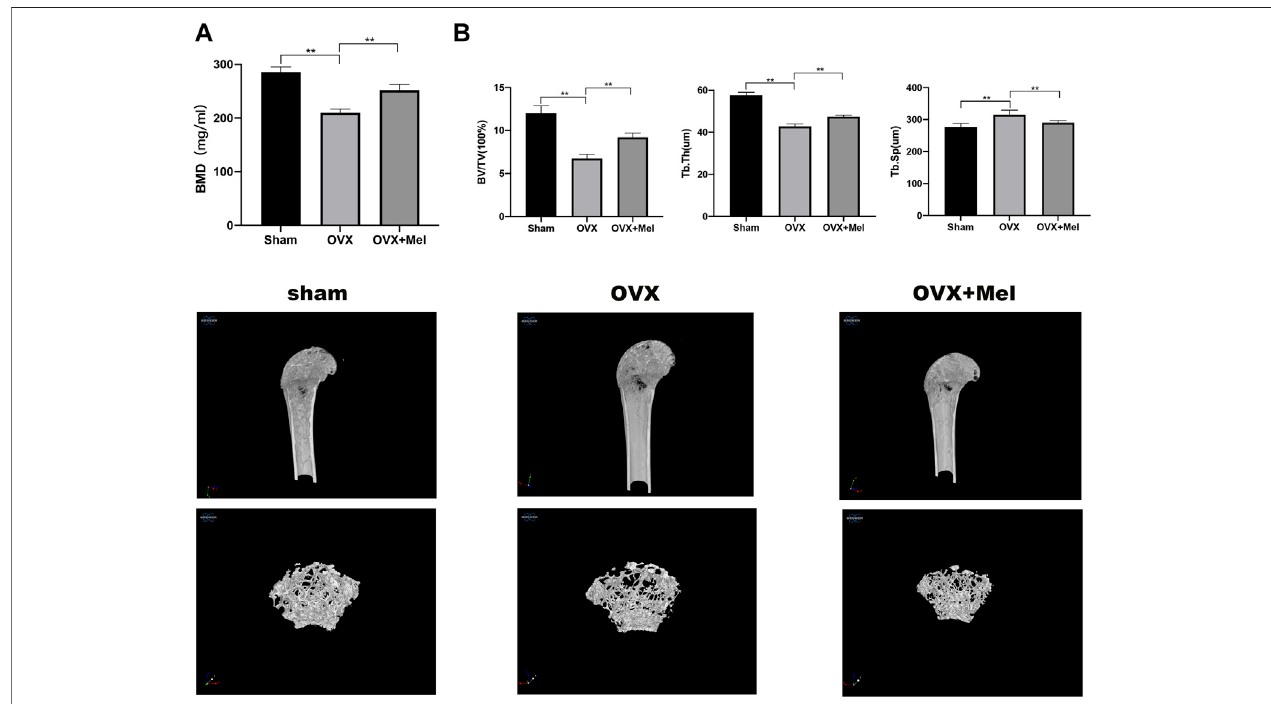
FIGURE 2 | Melatonin signi fi cantly reverses postmenopausal osteoporosis. (A) Bone mass was detected in the mouse femur by measuring bone density. (B) BV/ TV, Tb.Th, Tb.Sp indicators in the mouse femur were analyzed using micro-CT. Experiments were performed in triplicate, and data are presented as the means ± standard deviations. * p < 0.05 or ** p < 0.01 compared with control cells.